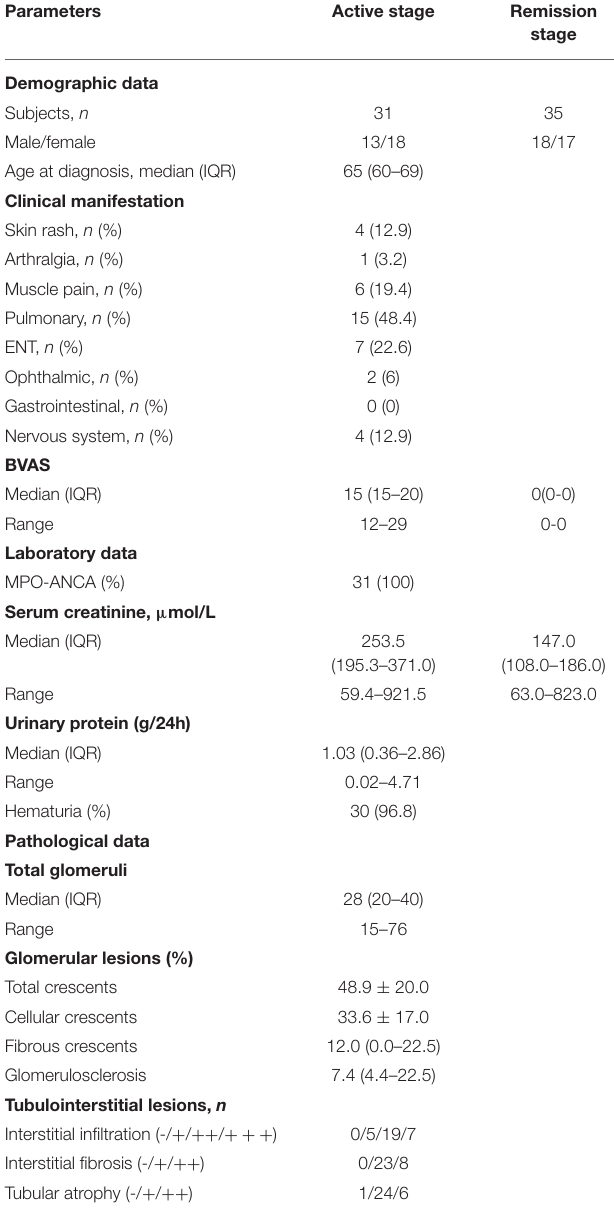
TABLE 1 | General data of patients with